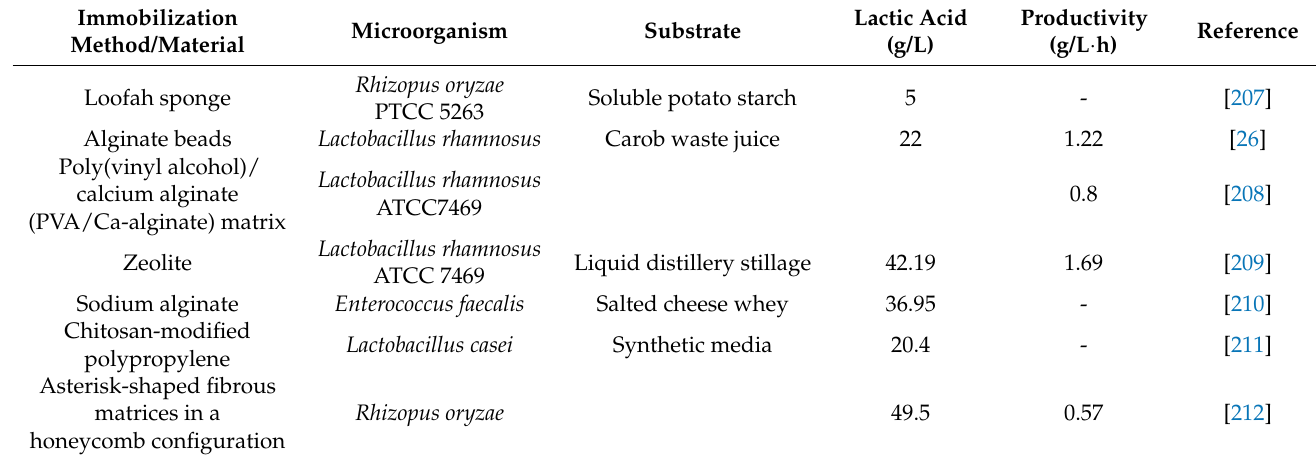
Table 2. List of recent reports on immobilization methods and their lactic acid yield.